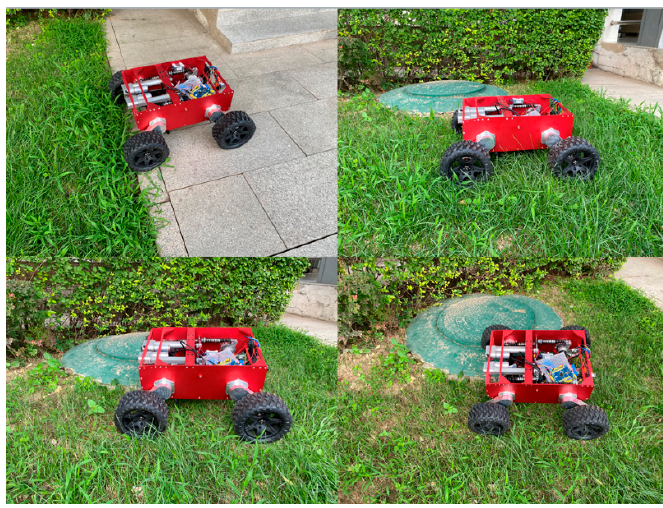
Figure 19. Robot grassland passed the experiment.